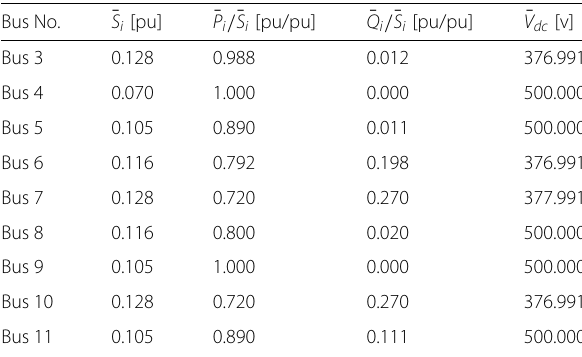
Table 1 Grid-connected scenario: Microgrid